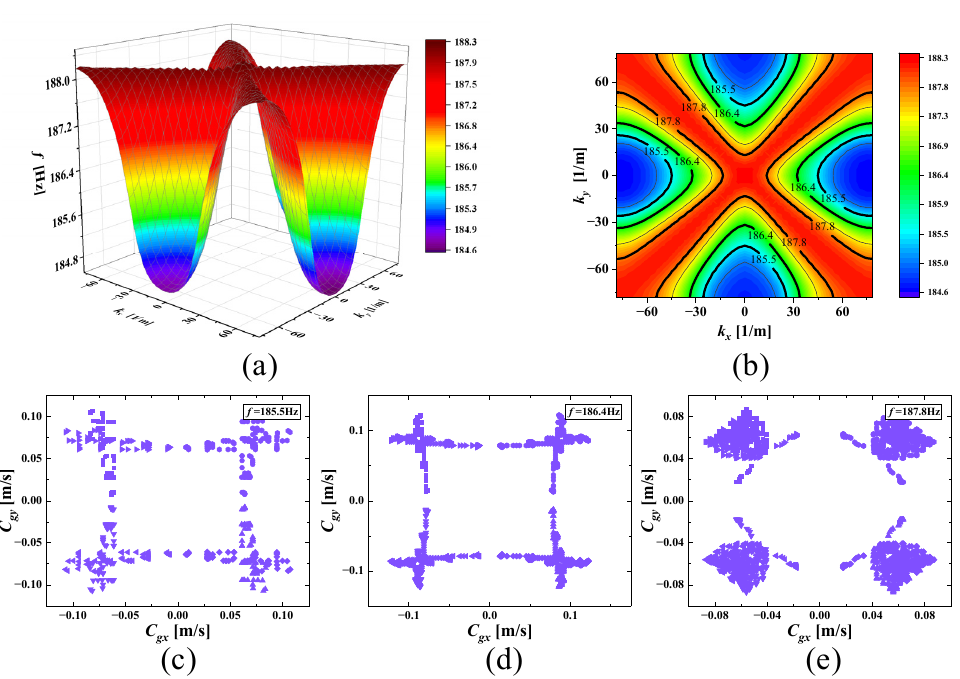
Figure 7. ( a ) Fourth mode; ( b ) ISO-frequency contours; ( c – e ) group velocity of fourth wave mode at 185.5 Hz, 186.4 Hz, and 187.8 Hz.